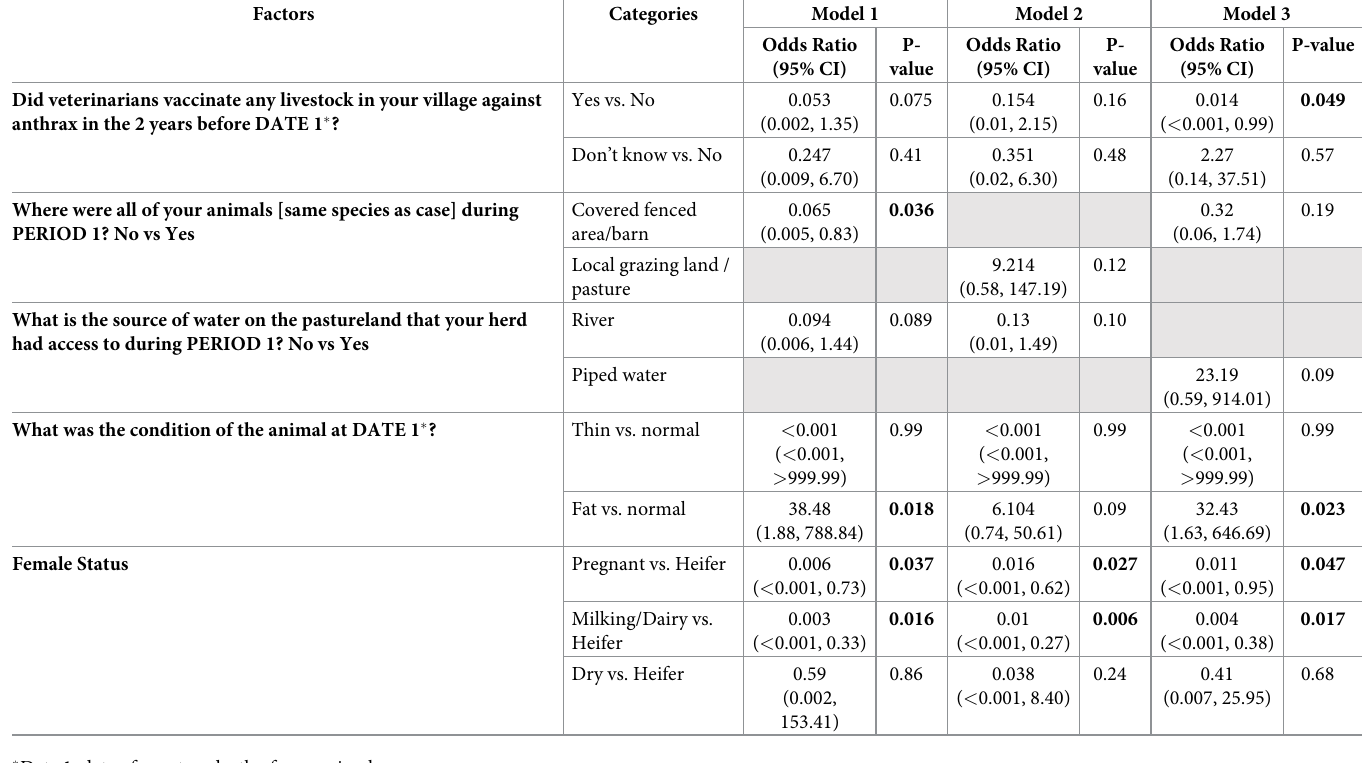
Table 4. Final multivariable conditional logistic regression models (Comparing cases to all